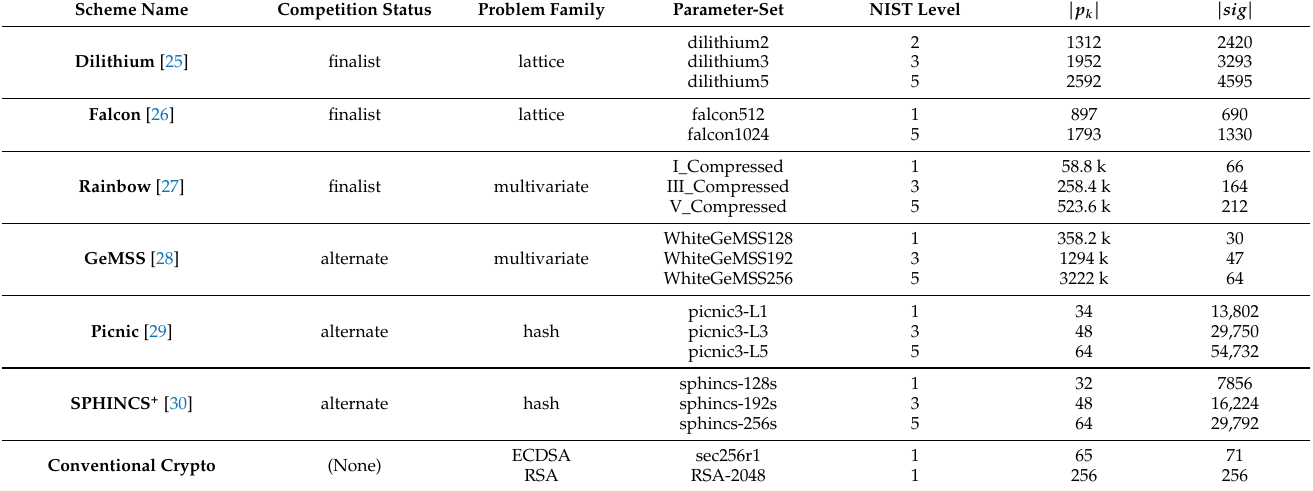
Table 2. US NIST Round 3 DSAs. The NIST Level shows the NIST security level according to Table 1; | p k | and | sig | denote the size of the public key and signature in bytes. We also included the state-of-the-art DSAs RSA and ECDSA for